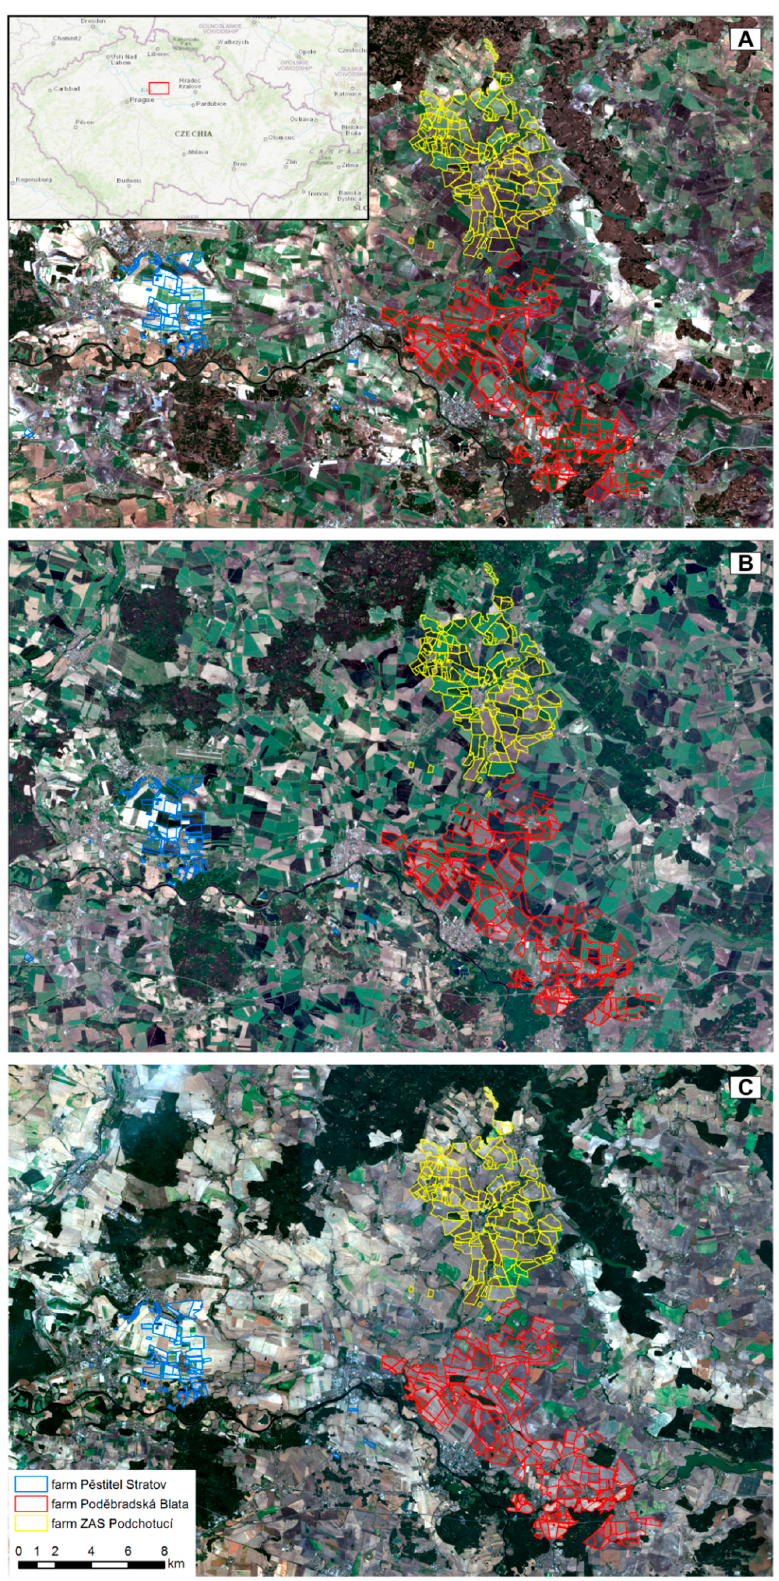
Figure A1. Location of agricultural parcels where campaigns were conducted together with true color Sentinel-2 images for the “early season” (6 April 2018; ( A )), “mid season” (14 May 2018; ( B )) and “late season” (19 August 2018; ( C )).